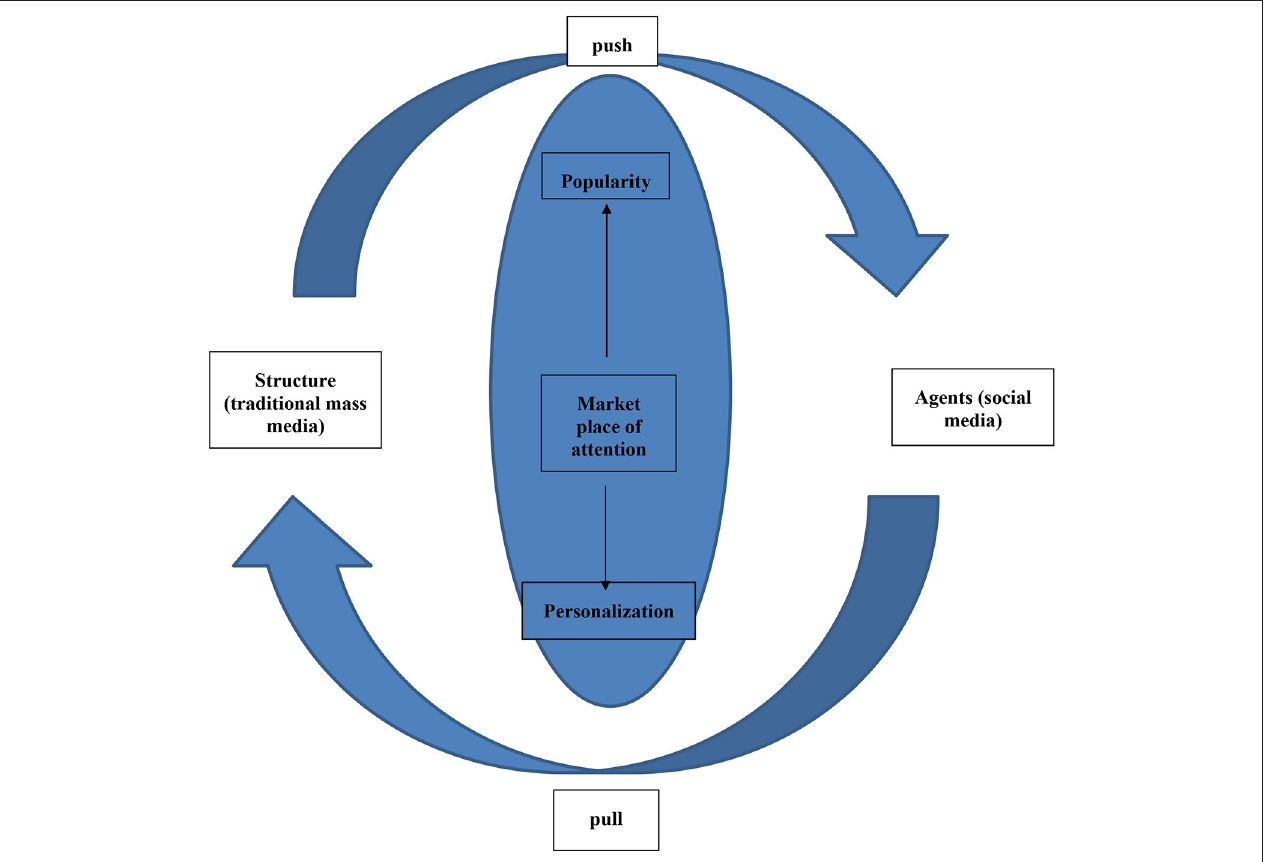
FIGURE 2 | Model of a cross media ecosystem (adapted from Webster,